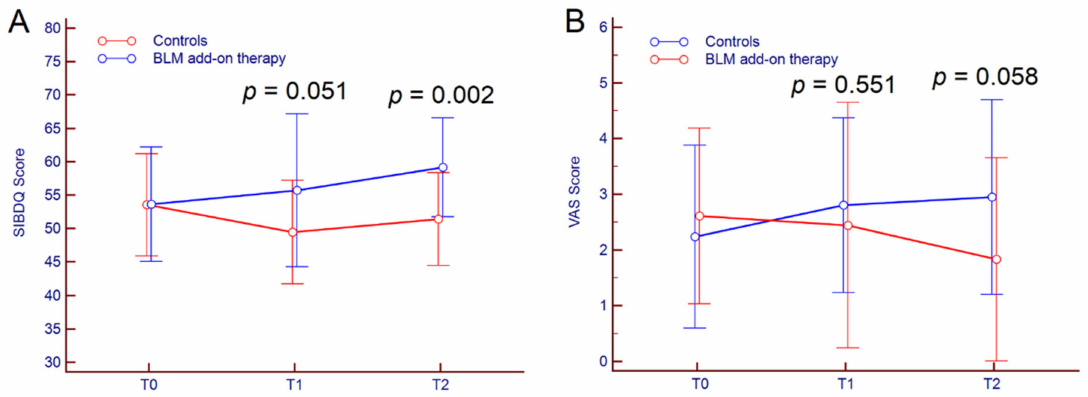
Figure 2. Kinetics of SIBDQ ( A ) and VAS ( B ) scores from T0 to T2 in UC patients treated with BLM add-on therapy and in the control group. Comparison between groups at di ff erent time-points was performed by Students’ t -test. Abbreviations: microencapsulated sodium butyrate (BLM), Short Inflammatory Bowel Disease Questionnaire (SIBDQ), visual analogue scale